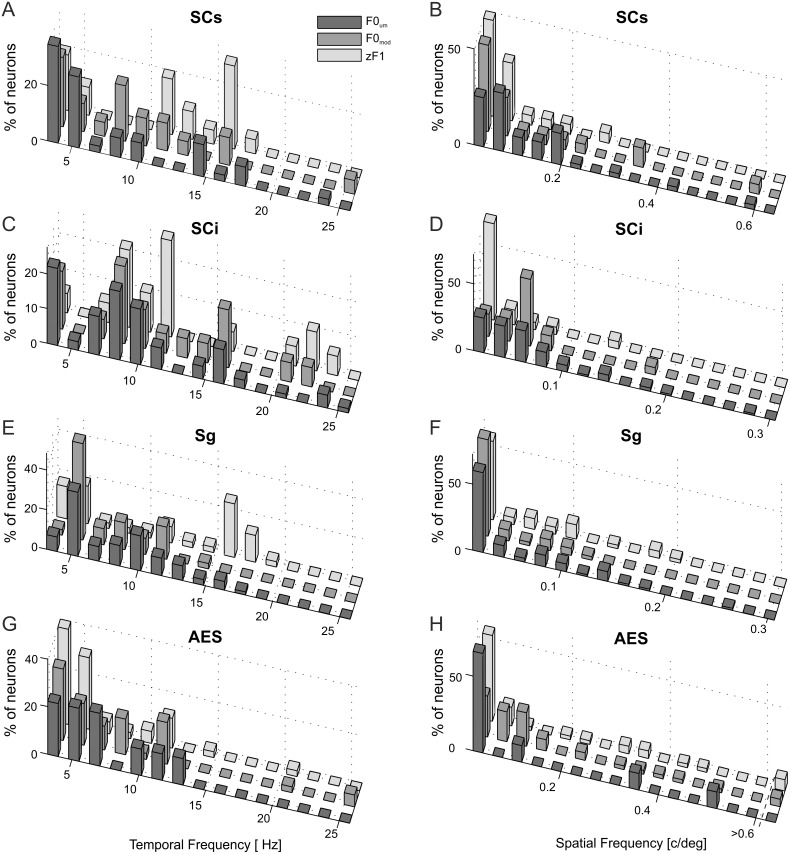
Distributions of temporal and spatial frequencies of gratings that maximized discharge rate and modulation.Shown are distributions of the optimal temporal (left column) and spatial (right column) frequencies of the gratings that evoked maximal discharge rates for neurons with unmodulated (dark grey, Rum), modulated (medium grey, Rmod) responses, and those that evoked a maximal zF1 for neurons with modulated responses (light grey, zF1mod). Note differences in the range of SF axes for different structures.